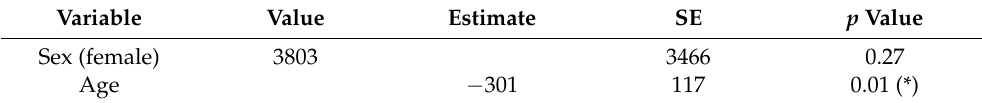
Table 3. Values and estimates of the univariate quantile regression for the influence of sex and age. Variable Value Estimate SE